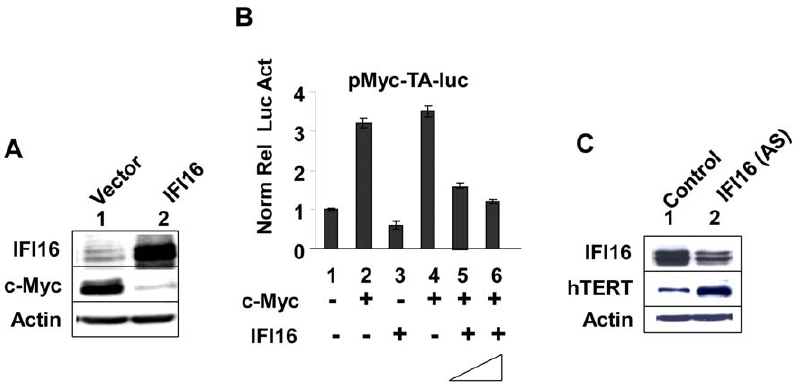
Figure 3. IFI16 inhibits c-Myc-stimulated transcription and hTERT expression in HeLa cells. ( A ) Total protein extracts prepared from HeLa cells infected with control retrovirus (lane 1) or a virus encoding IFI16 protein (lane 2) were subjected to immunoblotting using antibodies specific to the indicated proteins. ( B ) Sub-confluent cultures of HeLa cells were transfected with pMyc-TA-luc reporter plasmid (1.0 m g) along with a second pRL- TK reporter plasmid (0.2 m g) and an empty plasmid (pCMV; column 1), a plasmid encoding c-Myc (column 2 and 4), a plasmid encoding IFI16 (column 3), or both plasmids encoding c-Myc and increasing amounts of the plasmid encoding IFI16 protein (column 5 and 6). After 44–48 h of transfections, cells were lysed and the lysates were analyzed for dual luciferase activity. Normalized relative luciferase activity in control cells is indicated as 1.0. ( C ) Total protein extracts prepared from HeLa cells infected with control retrovirus (lane 1) or a virus encoding antisense to IFI16 mRNA (lanes 2) were subjected to immunoblotting using antibodies specific to the indicated